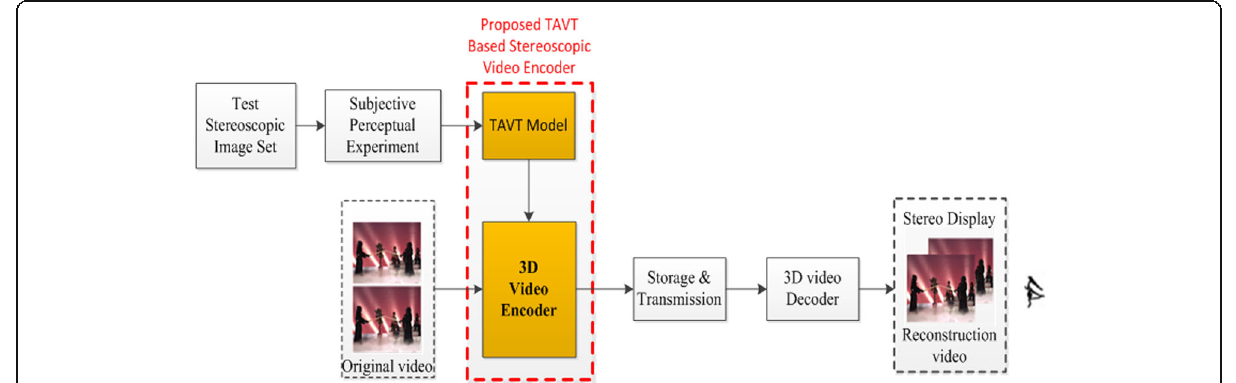
Fig. 1 Framework of the proposed stereoscopic video coding